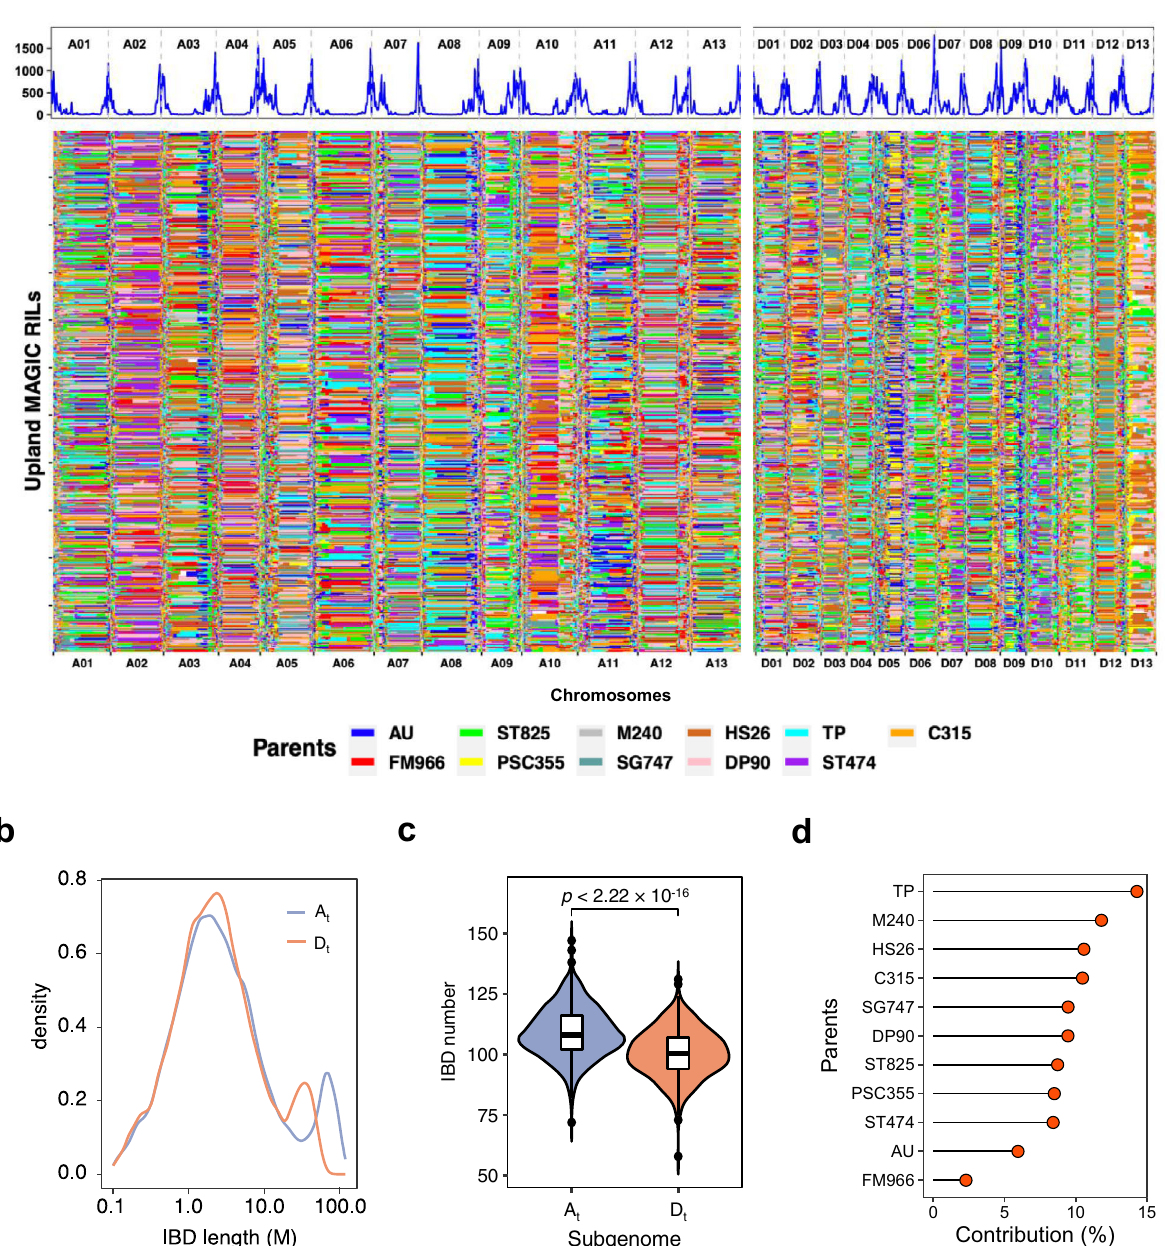
Fig. 2 IBD-based recombination pattern in the 550 MAGIC RILs across the genome. a The recombination pattern along the cotton chromosomes (top). Each estimated point indicates the mean value of recombination jointly in a 1-Mb sliding window across the 550 MAGIC RILs. IBD map for 11 founder parents (bottom). Each IBD block is assigned to the parent with the top probability, only if it is larger than 2 folds of expected value by chance (1/11), otherwise, it was considered with an unknown origin (in white). b Density plots of the length of IBD blocks in the A t and D t subgenomes. c Violin plots of IBD number of 550 MAGIC RILs in A t and D t subgenomes. P- value was calculated by a two-tailed Student ’ s t -test. d Global contribution of 11 parents in the MAGIC